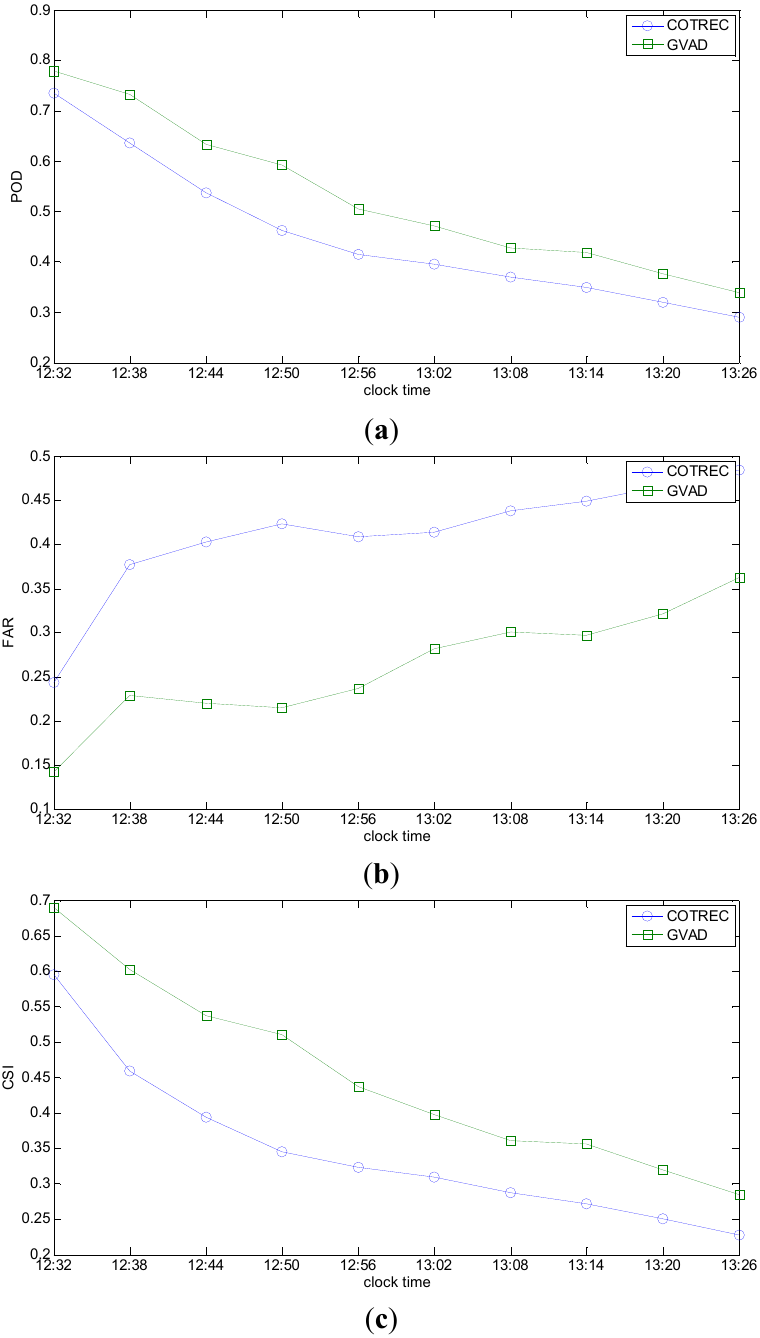
Figure 5. Testing of the Changsha case for each 6-min interval from 12:32 to 13:26 (UTC) on 11 April 2006. ( a ) POD; ( b ) FAR; ( c )